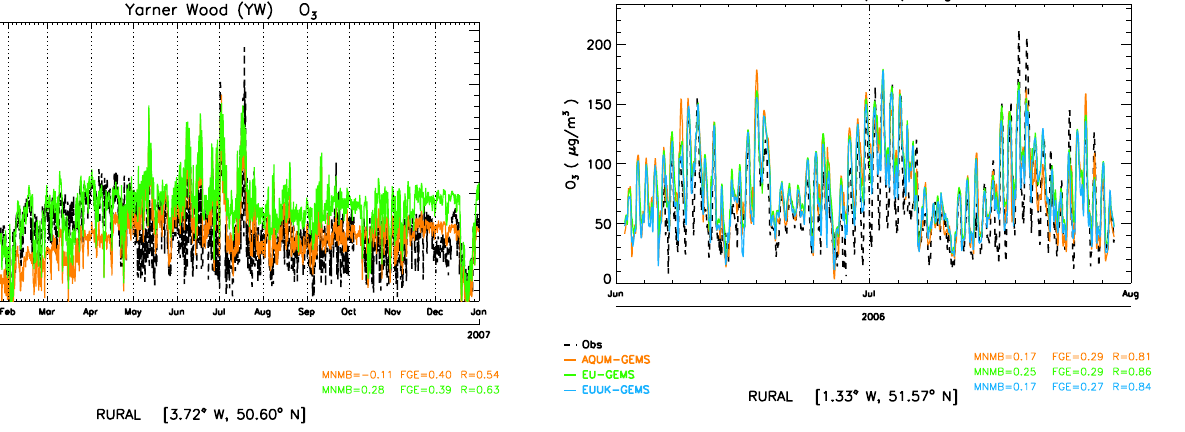
Fig. 14. Comparison of a year-long run of AQUM for 2006: results for ozone at the rural site Yarner Wood using LBCs from GEMS (orange) and MACC (green) reanalyses.